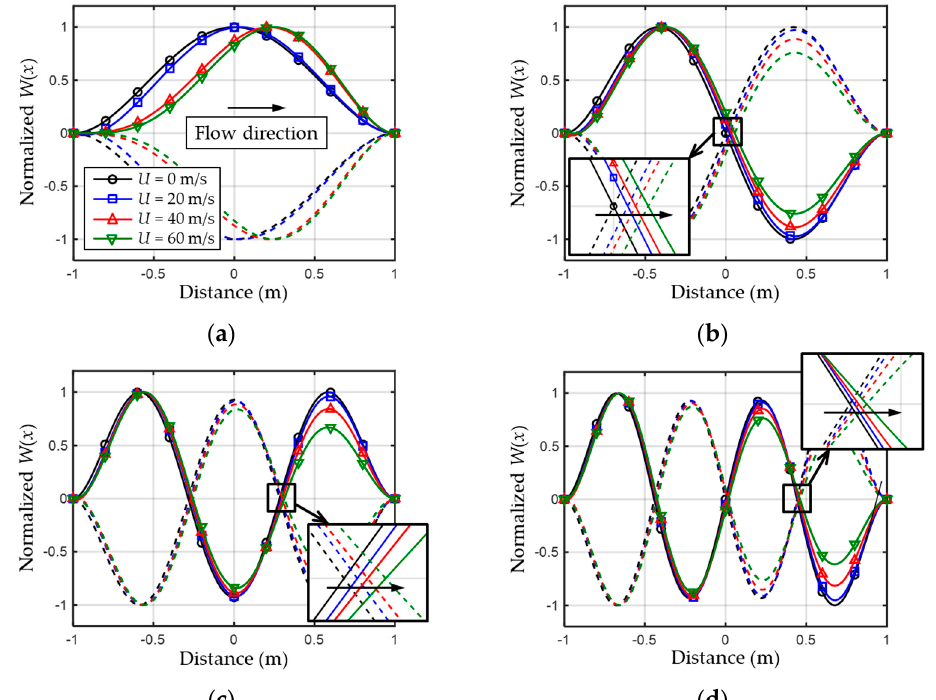
Figure 5. Analytical mode shapes of the fluid pipe when the flow velocity increased: ( a ) 1st, ( b ) 2nd, ( c ) 3rd, and ( d ) 4th mode shape.